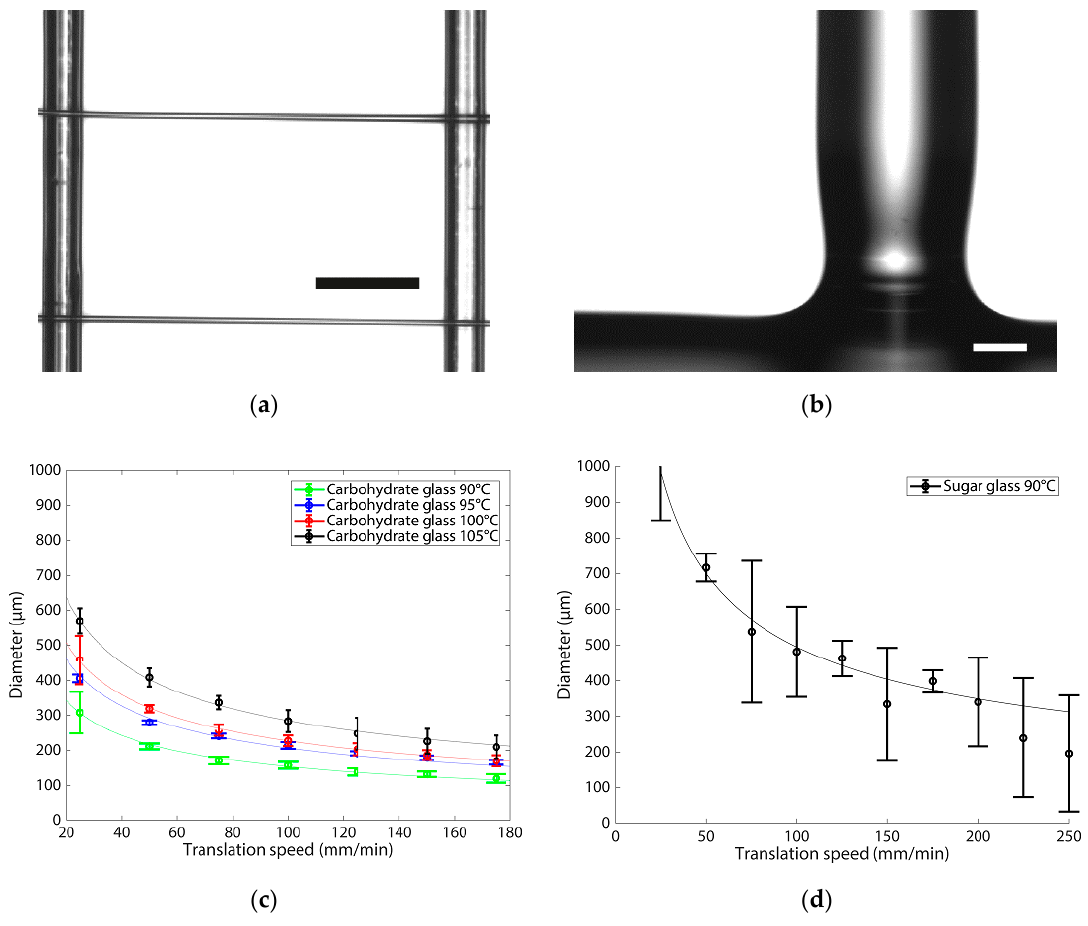
Figure 3. Relation between printed fibre diameter, nozzle translation speed and temperature for the carbohydrate glass and sugar glass fibres printed with a 0.15 mm nozzle. ( a ) setup to determine fibre diameter with two printed carbohydrate fibres suspended on top of the pre-printed framework, scale bar 1000 µ m; ( b ) Detailed image of the carbohydrate fibre connection with the framework, showing some degree of necking at the beginning of the fibre, scale bar 100 µ m; ( c ) Fibre diameter for the carbohydrate glass at di ff erent temperatures and translation speeds; ( d ) Fibre diameter for the sugar glass at 90 ◦ C, showing the e ff ect of lower viscosity on printing behaviour and quality. The fitted function is Equation (1) for glass fibre drawing with Q as the fitting parameter, with values given